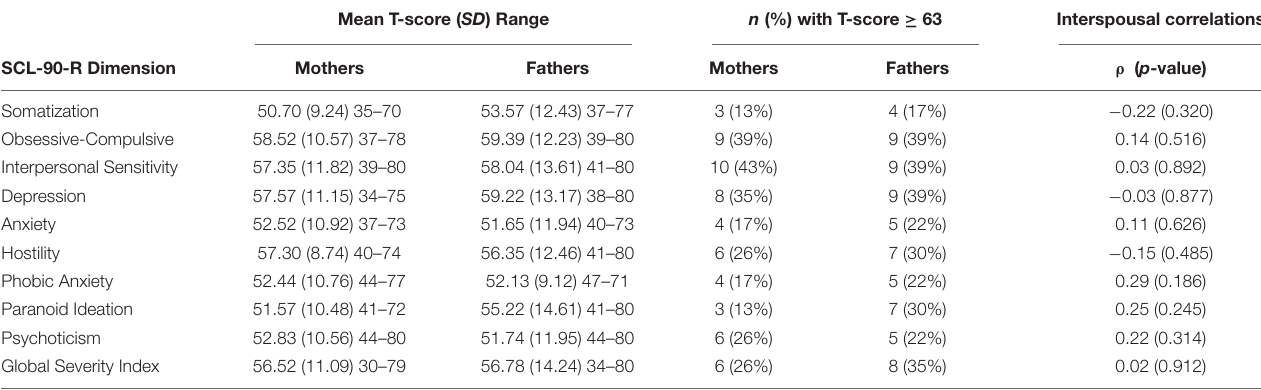
TABLE 2 | Mother-father comparisons of SCL-90-R dimension scores ( n = 46). Mean T-score ( SD ) Range n (%) with T-score ≥ 63 Interspousal correlations SCL-90-R Dimension Mothers